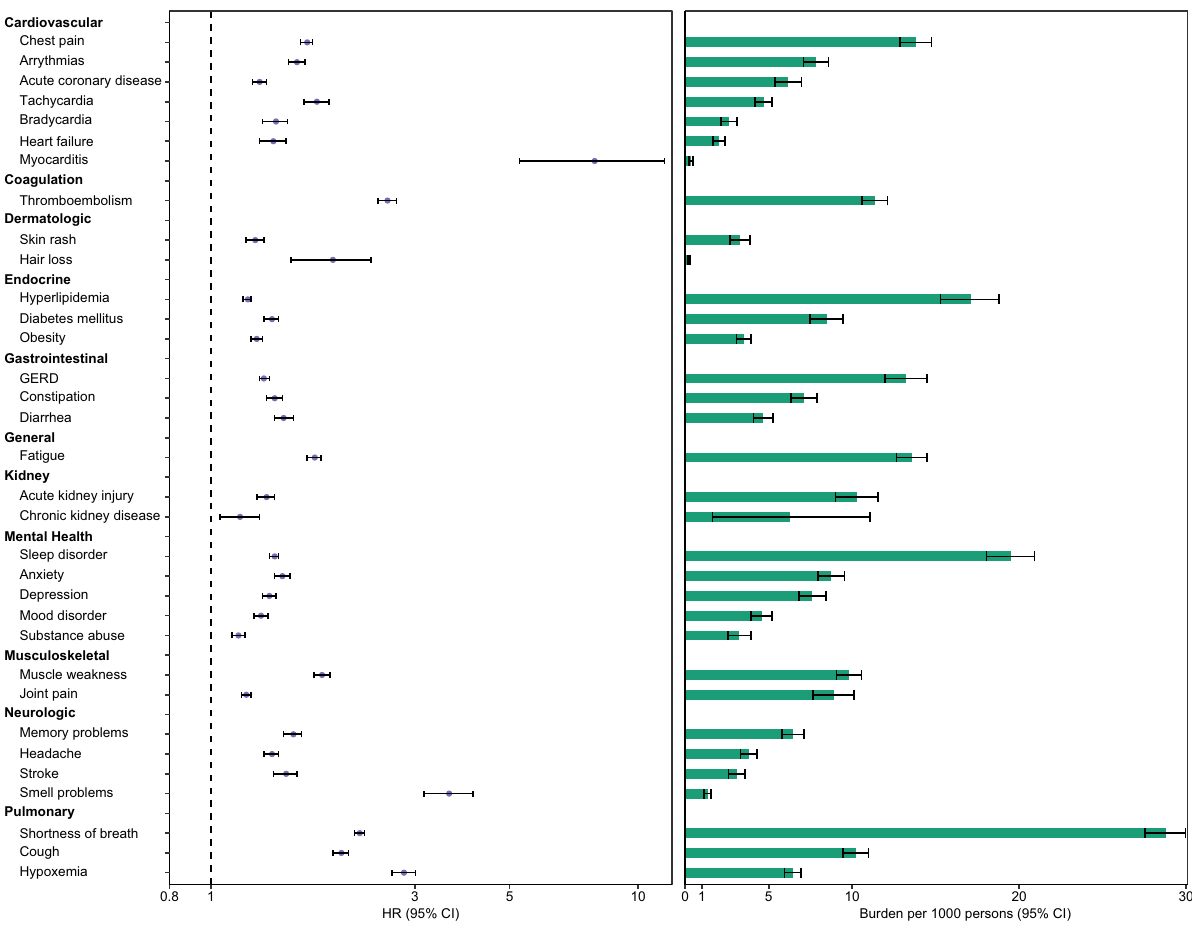
Fig. 1 Risks and burdens of post-acute sequelae of SARS-CoV-2 infection (PASC). Organ systems are presented in bolded font. Post-acute sequelae were ascertained from 30 days after infection until the end of follow-up. Hazard ratio and 95% con fi dence intervals are presented in the left panel and burdens per 1000 COVID-19 patients at 6 months are presented in the right panel; right limit of the bar represents estimated burden and error bars represent the 95% con fi dence interval. Models were adjusted for age, race, sex, receipt of long-term care, Area Deprivation Index, number of outpatient encounters, number of hospital admissions, number of outpatient prescriptions, number of outpatient serum creatinine measurements, chronic lung disease, cancer, cardiovascular disease, cerebrovascular disease, dementia, diabetes mellitus, hypertension, hyperlipidemia, depression, anxiety, chronic kidney disease, hepatitis C and peripheral artery disease, overweight, obesity, smoking status, Charlson Comorbidity Index, US geographic region, total number of beds, number of COVID-19 tests administered, COVID-19 positivity rate, and average hospital bed occupancy during the week of participant enrollment. NATURE COMMUNICATIONS| (2021) 12:6571